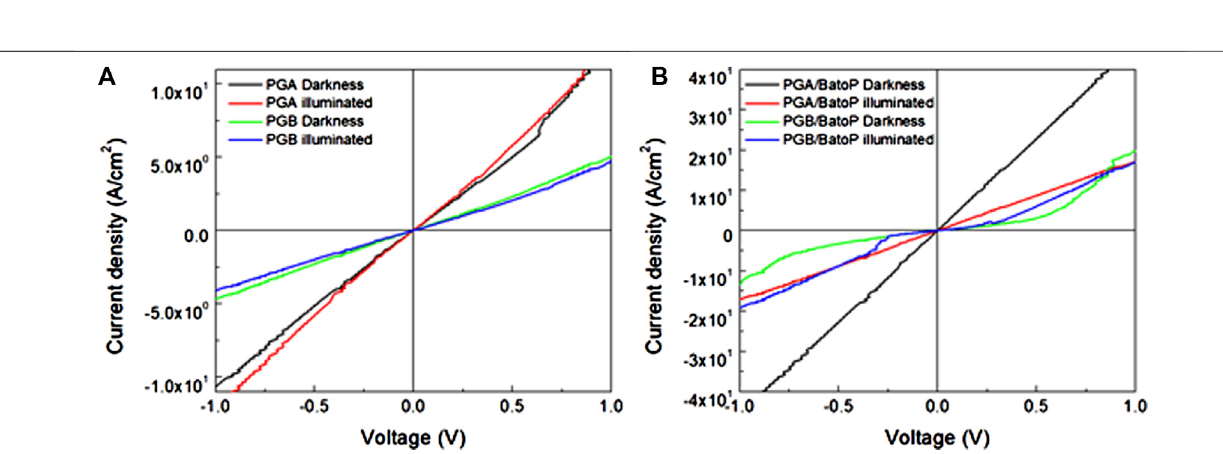
Frontiers in Materials |